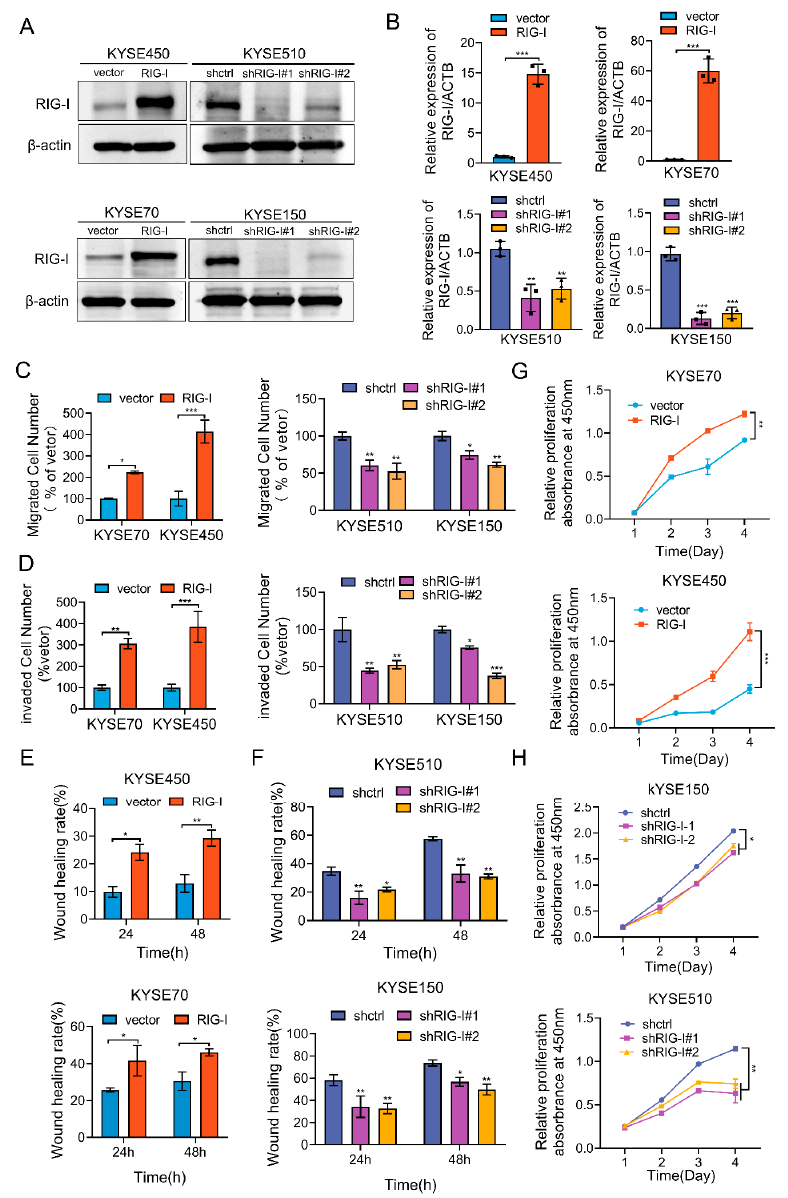
Figure 2. Effects of RIG-I overexpression (KYSE150 and KYSE510) and silencing (KYSE70 and KYSE450) on proliferation, migration, and invasion of ESCC cells. ( A ) RIG-I protein expression was detected using Western blotting and ( B ) mRNA level was detected using qRT-PCR. The mRNA values of three independent experiments were shown black dot, triangle and block. ACTB was used as